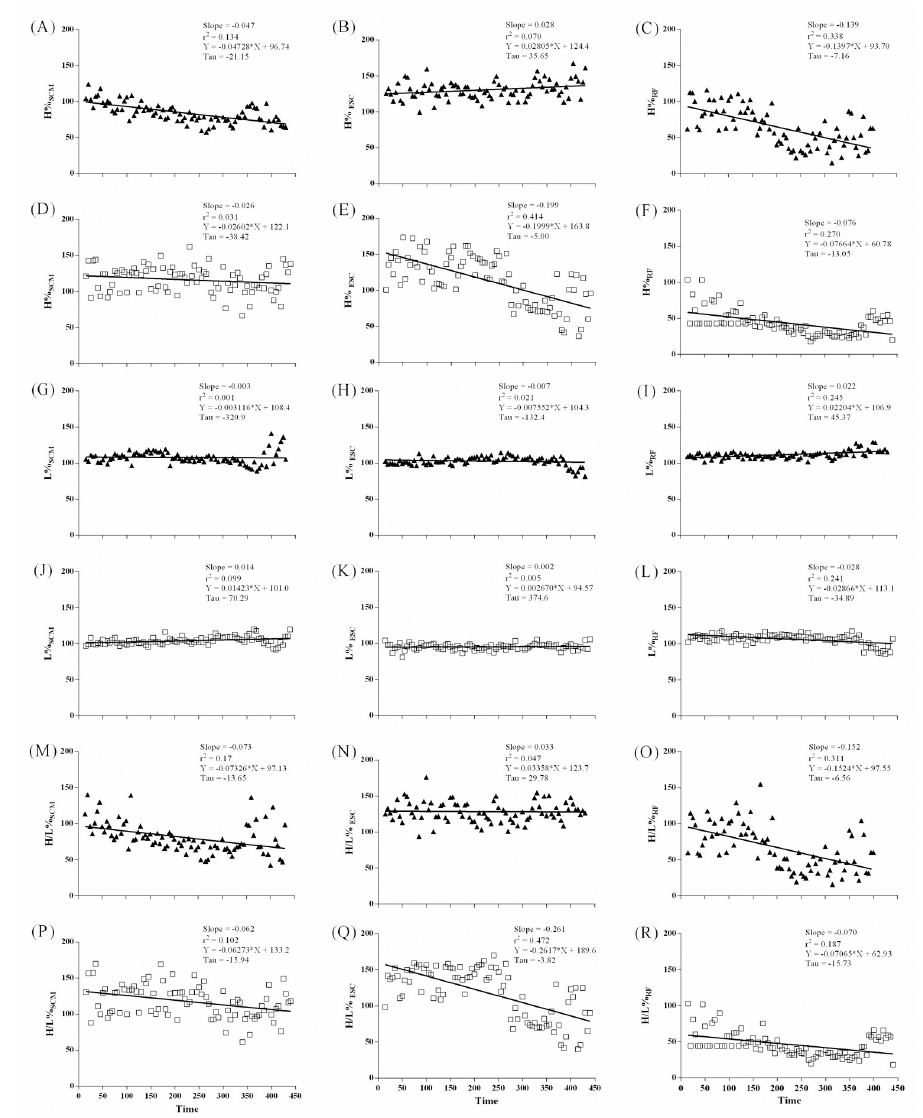
Fig 6. The high and low frequency bands, and high/low ratio of SCM (A, D, G, J, M and P), ESC (B, E, H, K, N and Q), and RF (C, F, I, O and R) muscles on ISWT moments, in COPD group (close triangles) and control group (open